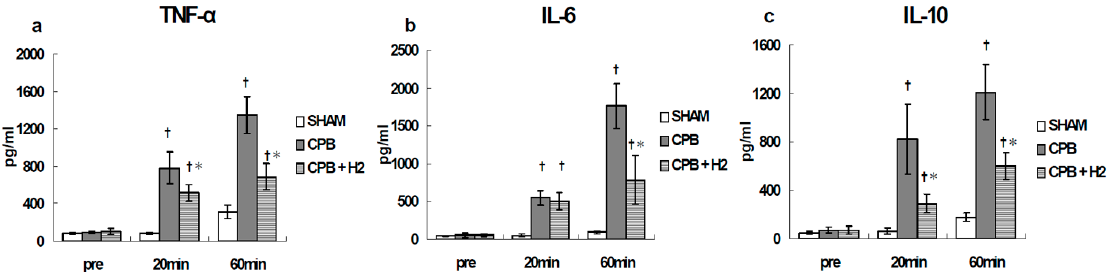
Figure 9. Plasma TNF- α ( a ), IL-6 ( b ), and IL-10 ( c ) [24]. † p < 0.05 versus the SHAM group, * p < 0.05 versus the CPB group at the same point in time.